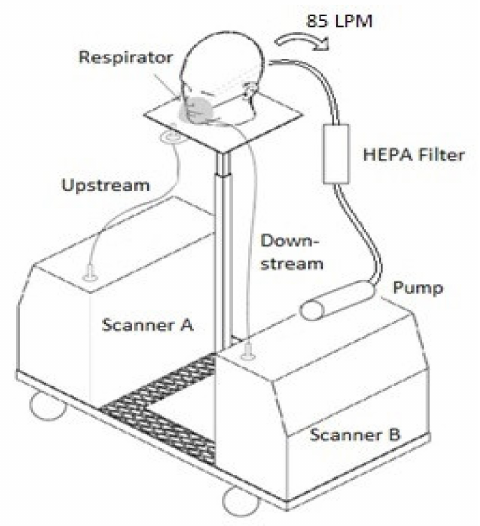
Figure 1. Schematic diagram of a respirator testing